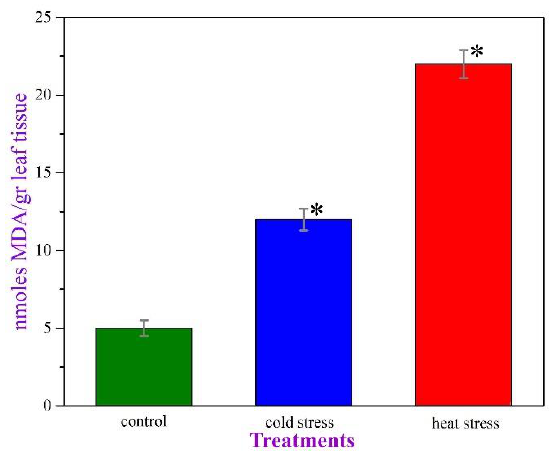
Figure 3. The oxidative stress — ROS — as measured for all three groups of P. lentiscus plants. Differ- ences were considered as statistically significant when p < 0.05 (*). Error bars represent the standard error of the mean (SEM, N = 4, n = 1).